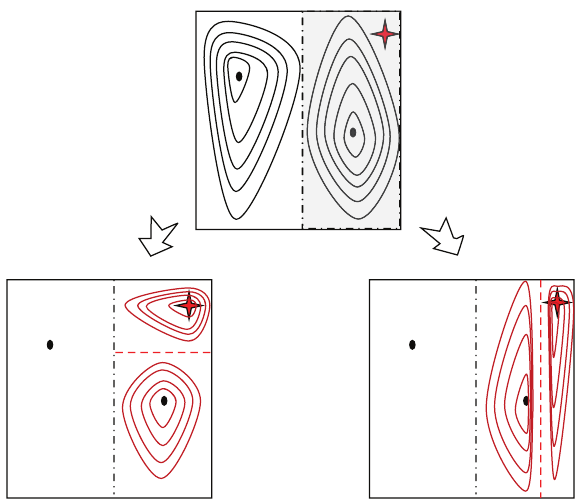
Figure 1: Finding the worst data point in the selected region as the new neuron center in